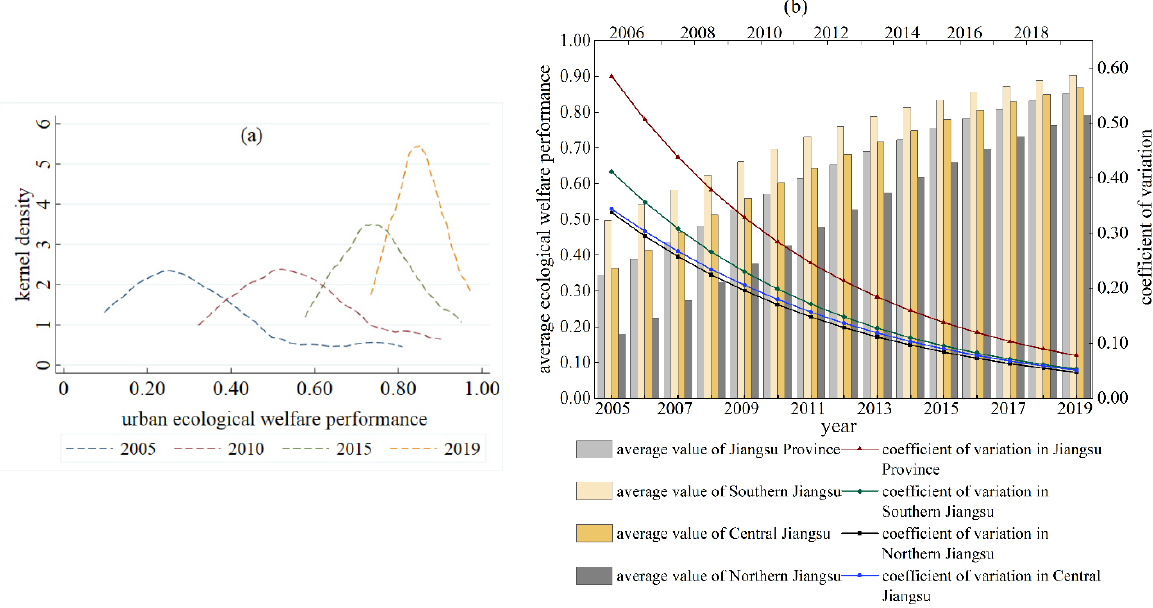
Figure 3. ( a ) shows the kernel density of urban eco-welfare performance in Jiangsu Province, 2005 – 2019,and ( b ) shows the trend of urban eco-welfare performance in Jiangsu Province, 2005–